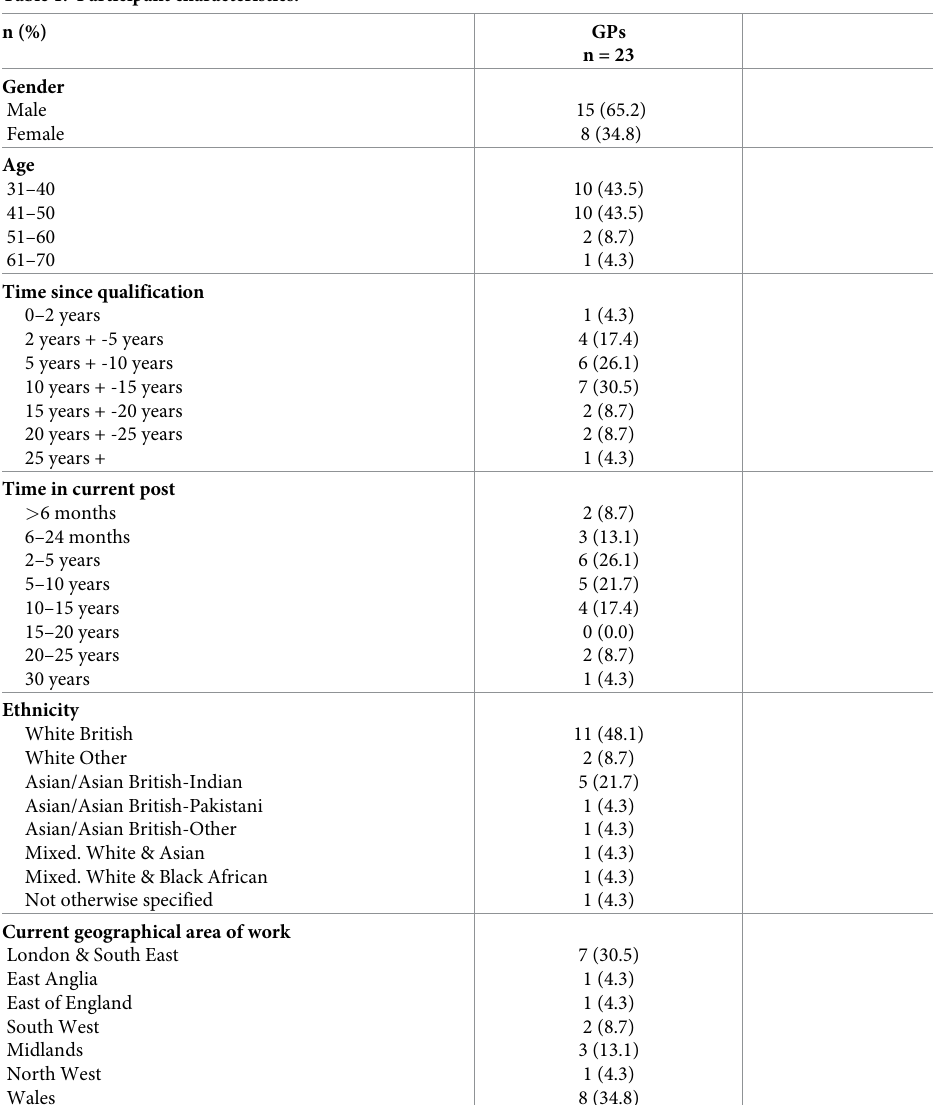
Table 1. Participant